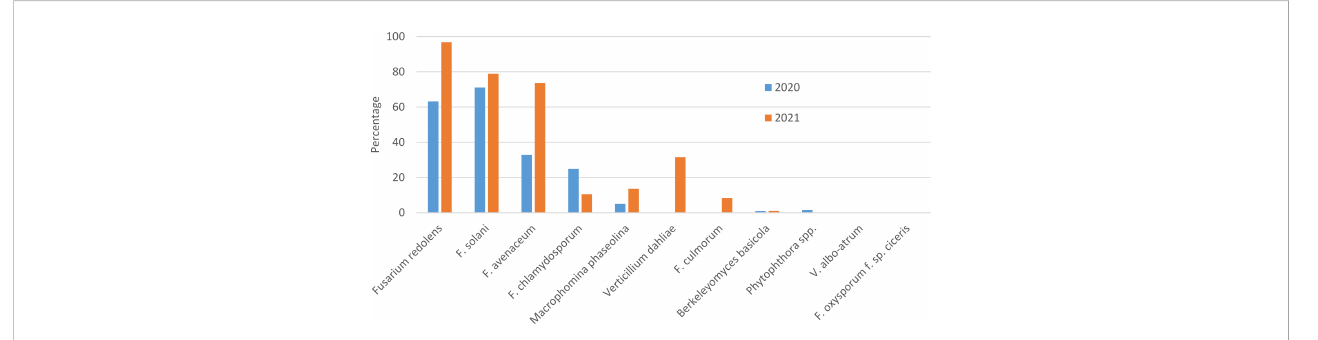
FIGURE 1 Percentage of chickpea root samples collected in Saskatchewan in 2020 and 2021 in which potential chickpea root pathogens were detected by end- point